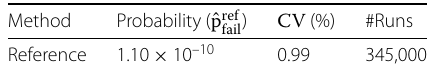
Table 3 VCO: reference probability estimation